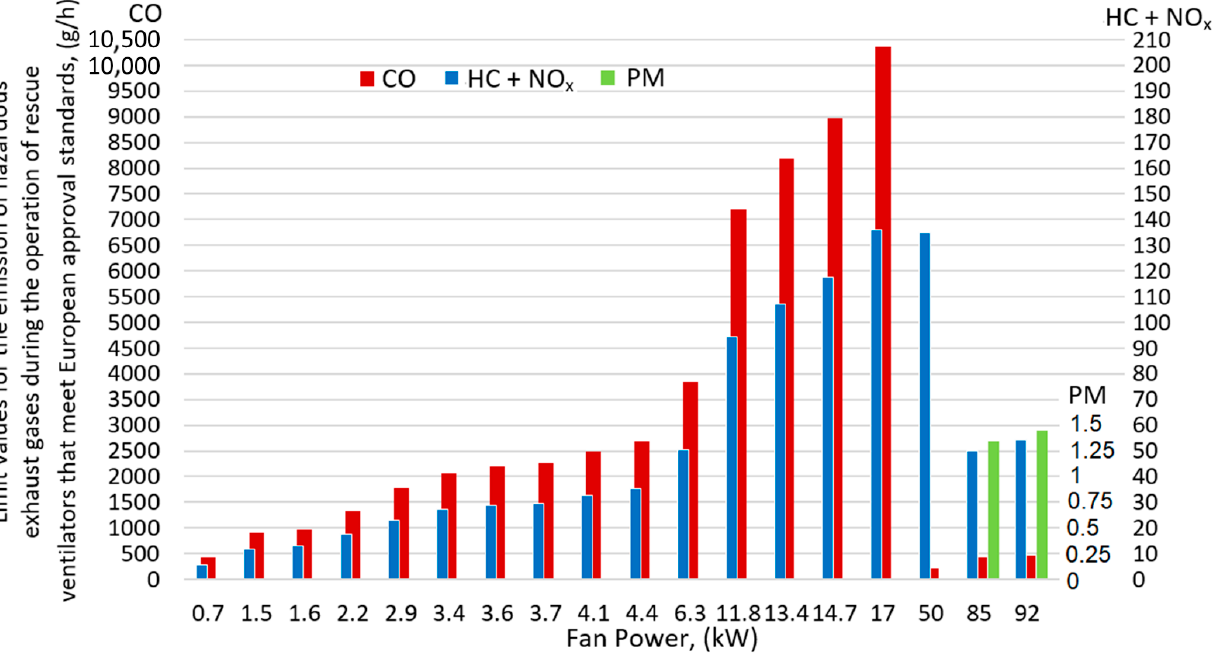
Figure 4. Estimated emissions from internal combustion engines of fans used in rescue operations per hour of work, determined on the basis of maximum air pollution emission limits in force during type-approval tests in the European Union area.